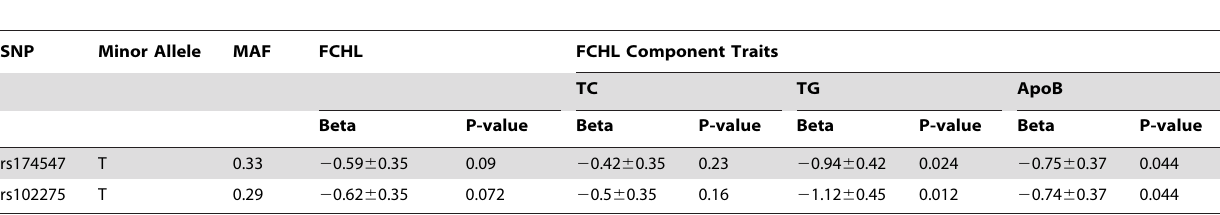
Table 5. Replication of association evidence for FADS1-2-3 locus in 70 Mexican FCHL case/control fat biopsies with qualitative lipid traits.